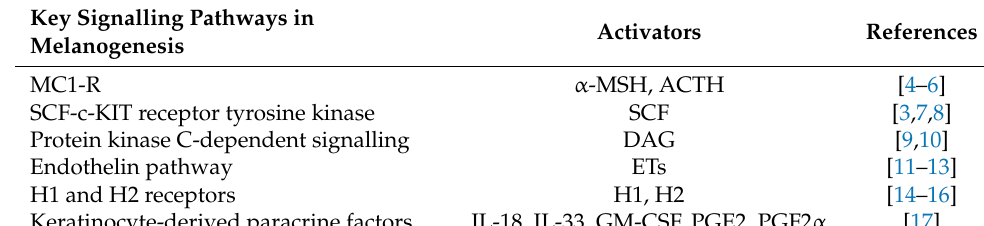
Table 1. Main activators of the melanogenesis pathways.